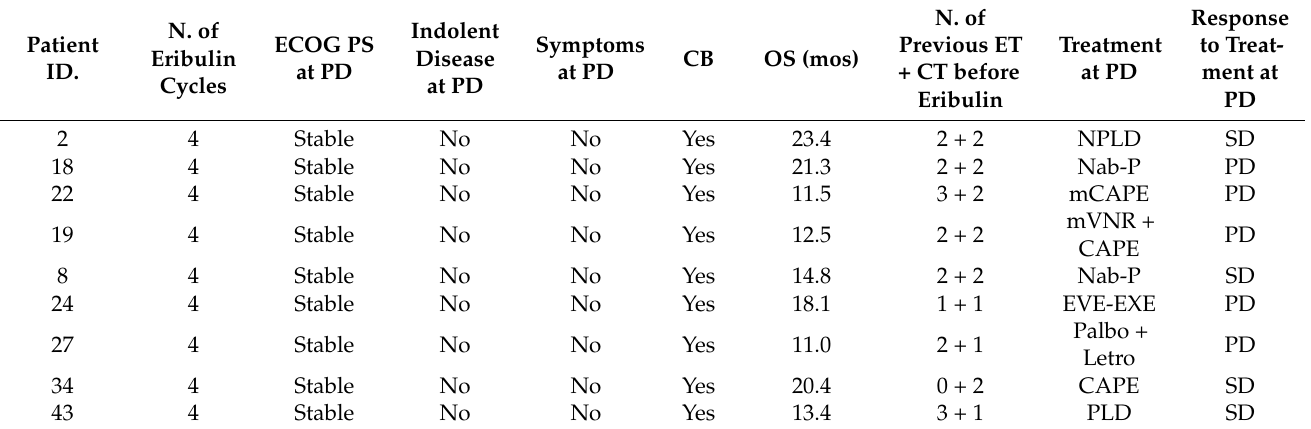
Table 2. Group 2 patients’ characteristics.